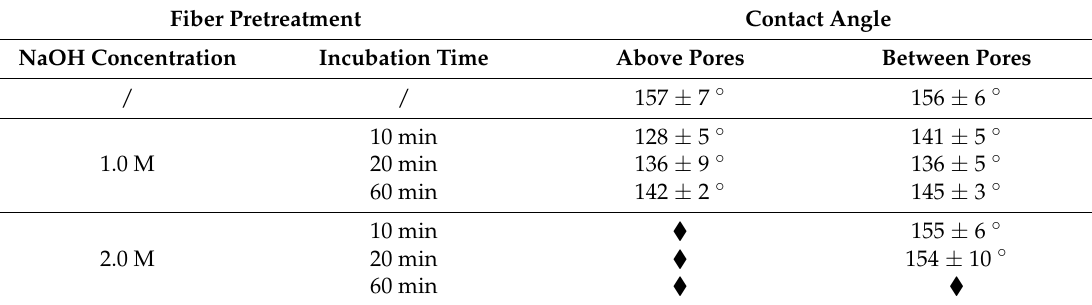
Fiber Pretreatment Contact Angle Incubation